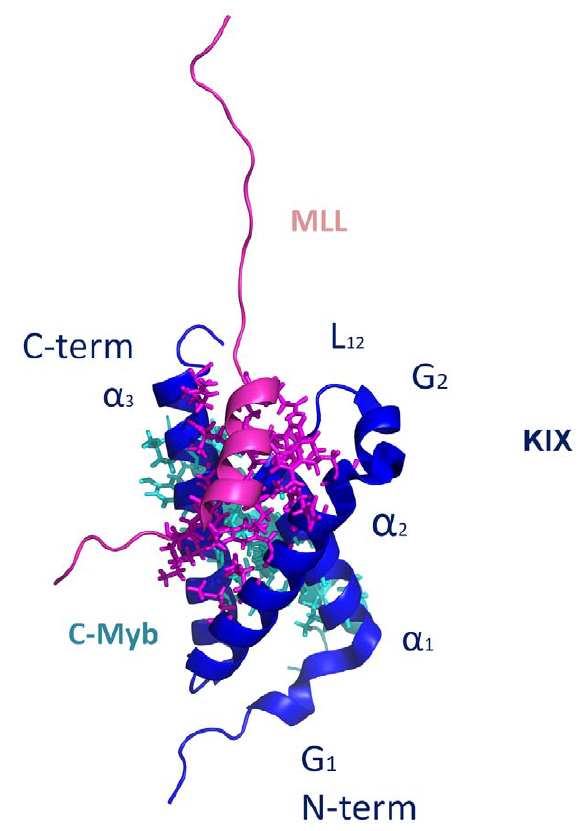
Figure 1. Structure of c-Myb:KIX:MLL ternary complex. 3-D Representation of the c-Myb:KIX:MLL (PDB id: 2AGH [11]) structure using PyMOL [44]. KIX, MLL and c-Myb structures are shown in purple, pink and cyan respectively. Secondary structure elements are labeled on KIX. The regions shown in sticks representations are the sites on KIX that are in contact with MLL (pink) and c-Myb (cyan).